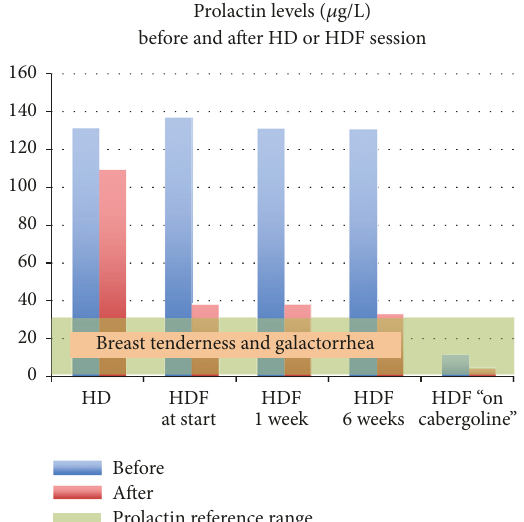
Figure 1: Prolactin levels ( 𝑦 -axis) before and after four-hour HD and HDF session (with or without cabergoline). Prolactin reference range: 2.2–30.3 𝜇